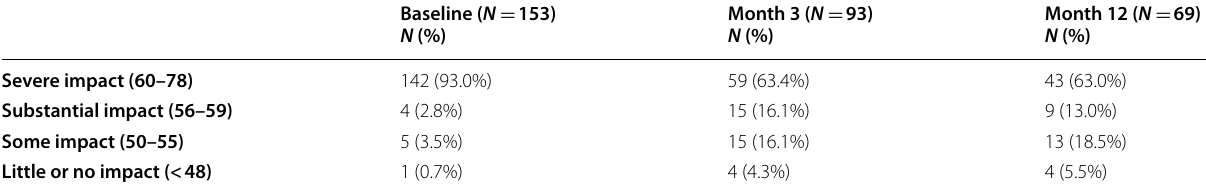
Table 4 Headache impact test‑6 (HIT‑6) headache disability categories at baseline and HIT‑6 changes after daily single‑pulse transcranial magnetic stimulation treatment for all patients at month 3 and for those who continued using the treatment at month